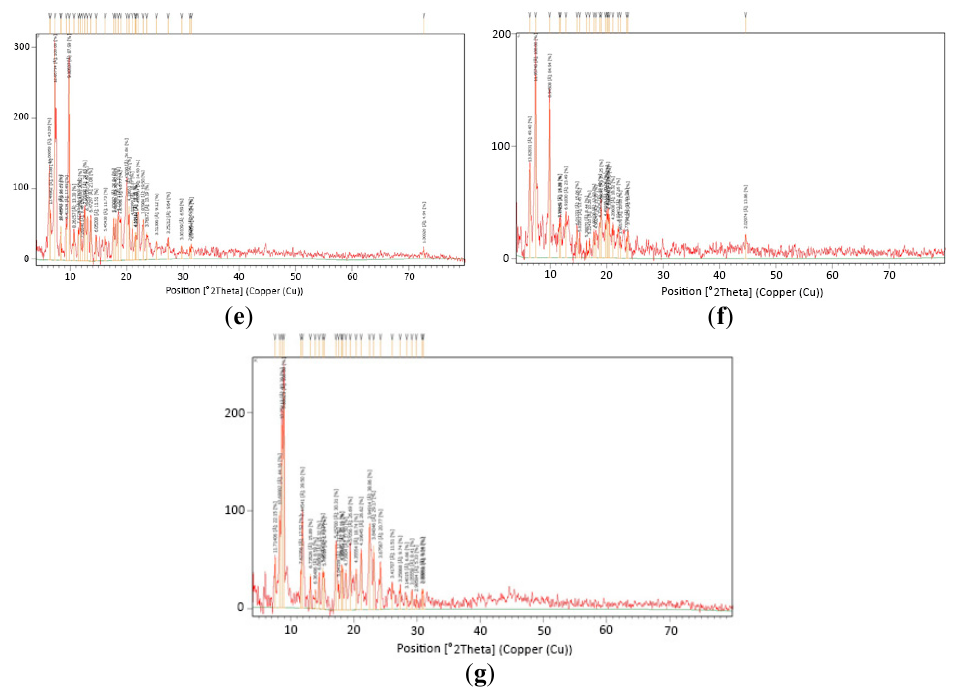
Figure 5. X-ray diffraction patterns of: fenoprofen calcium dihydrate ( a ); TA- β -CD ( b ); HPMC ( c ); EC ( d ); drug-TA- β -CD complex 1:3 ( e ); HPMC/drug complex ( f ); EC/drug complex ( g ). Note: The red color in each graph is characteristic for each substance respectively as shown in the figure caption and the yellow color is just a mark to indicate the peaks position and heights.